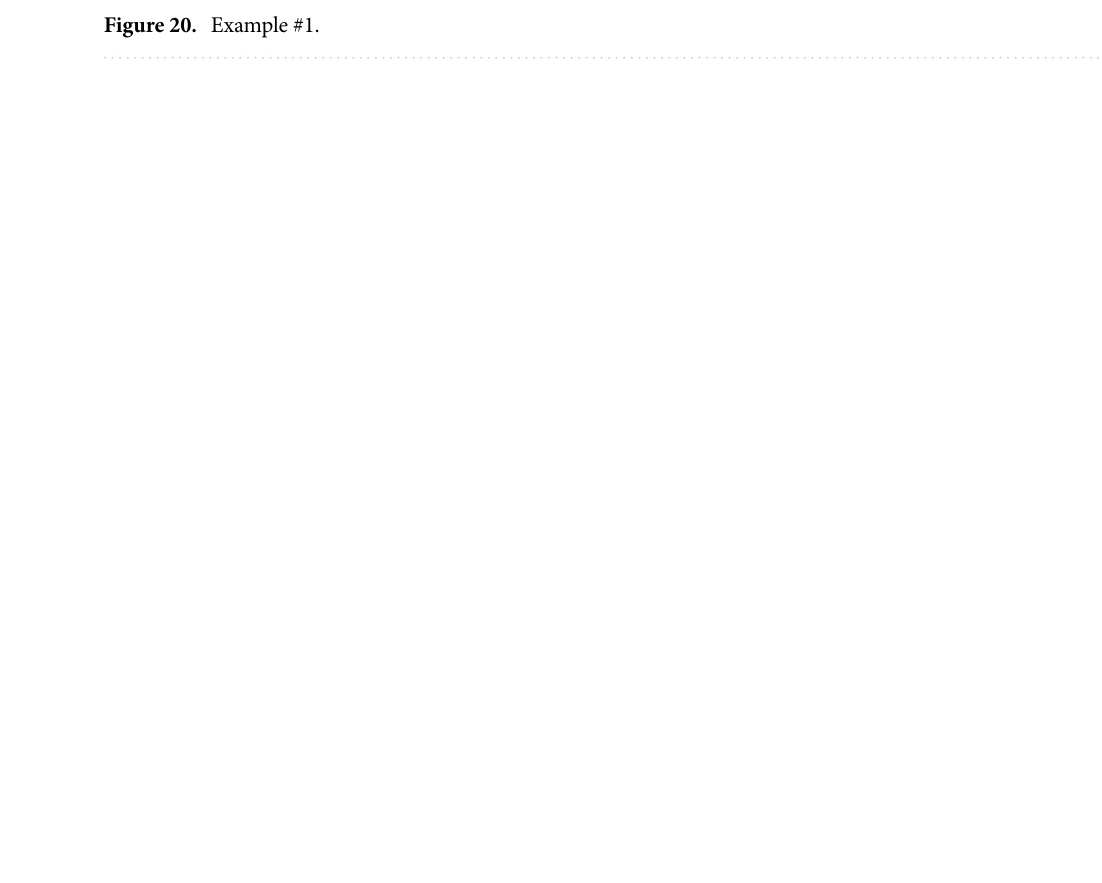
Figure 20. Example